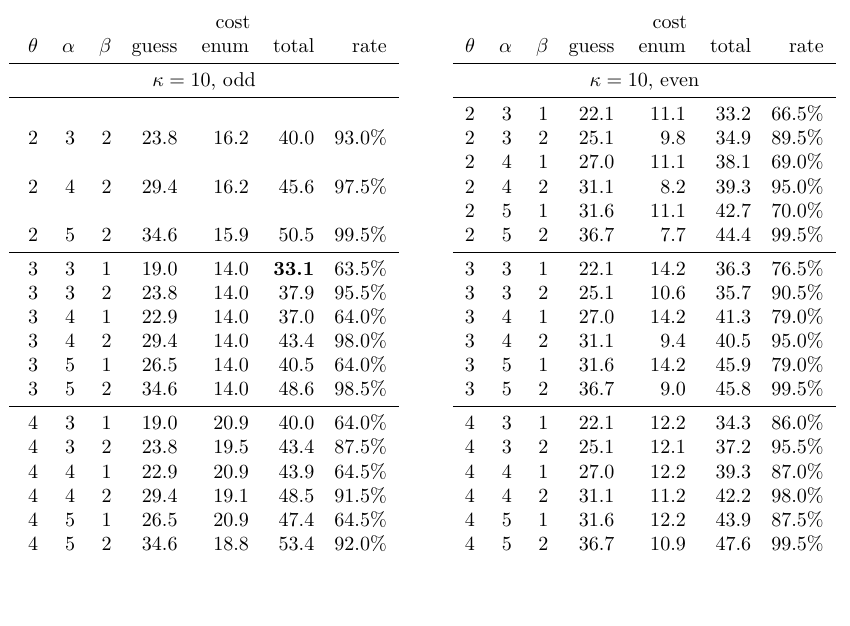
Table 8: Experimental results for Kyber parameters and κ = 10 ( ρ 0 = 0 . 5%, ρ 1 = 0 . 1%). For details see Table 7.